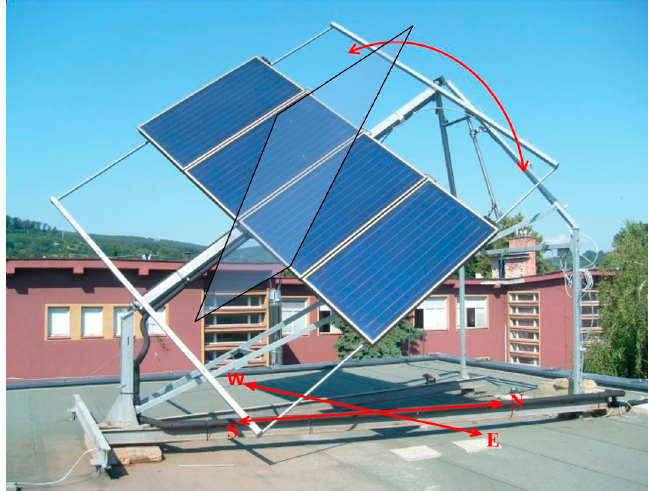
Figure 1. Solar panels installed on the tracker construction allowing the collectors to be tilted.